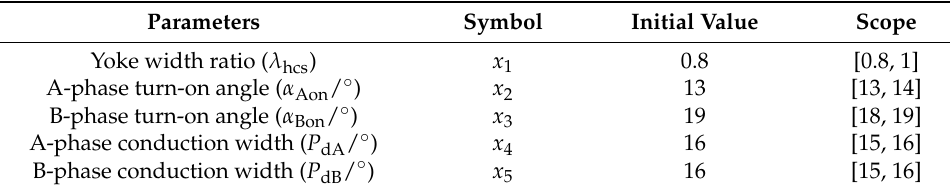
Table 2. Optimization parameters and their range.